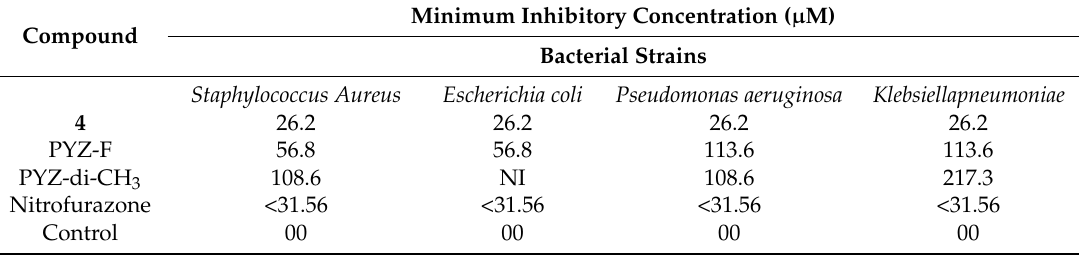
Table 3. Antibacterial activity of compound 4 and its